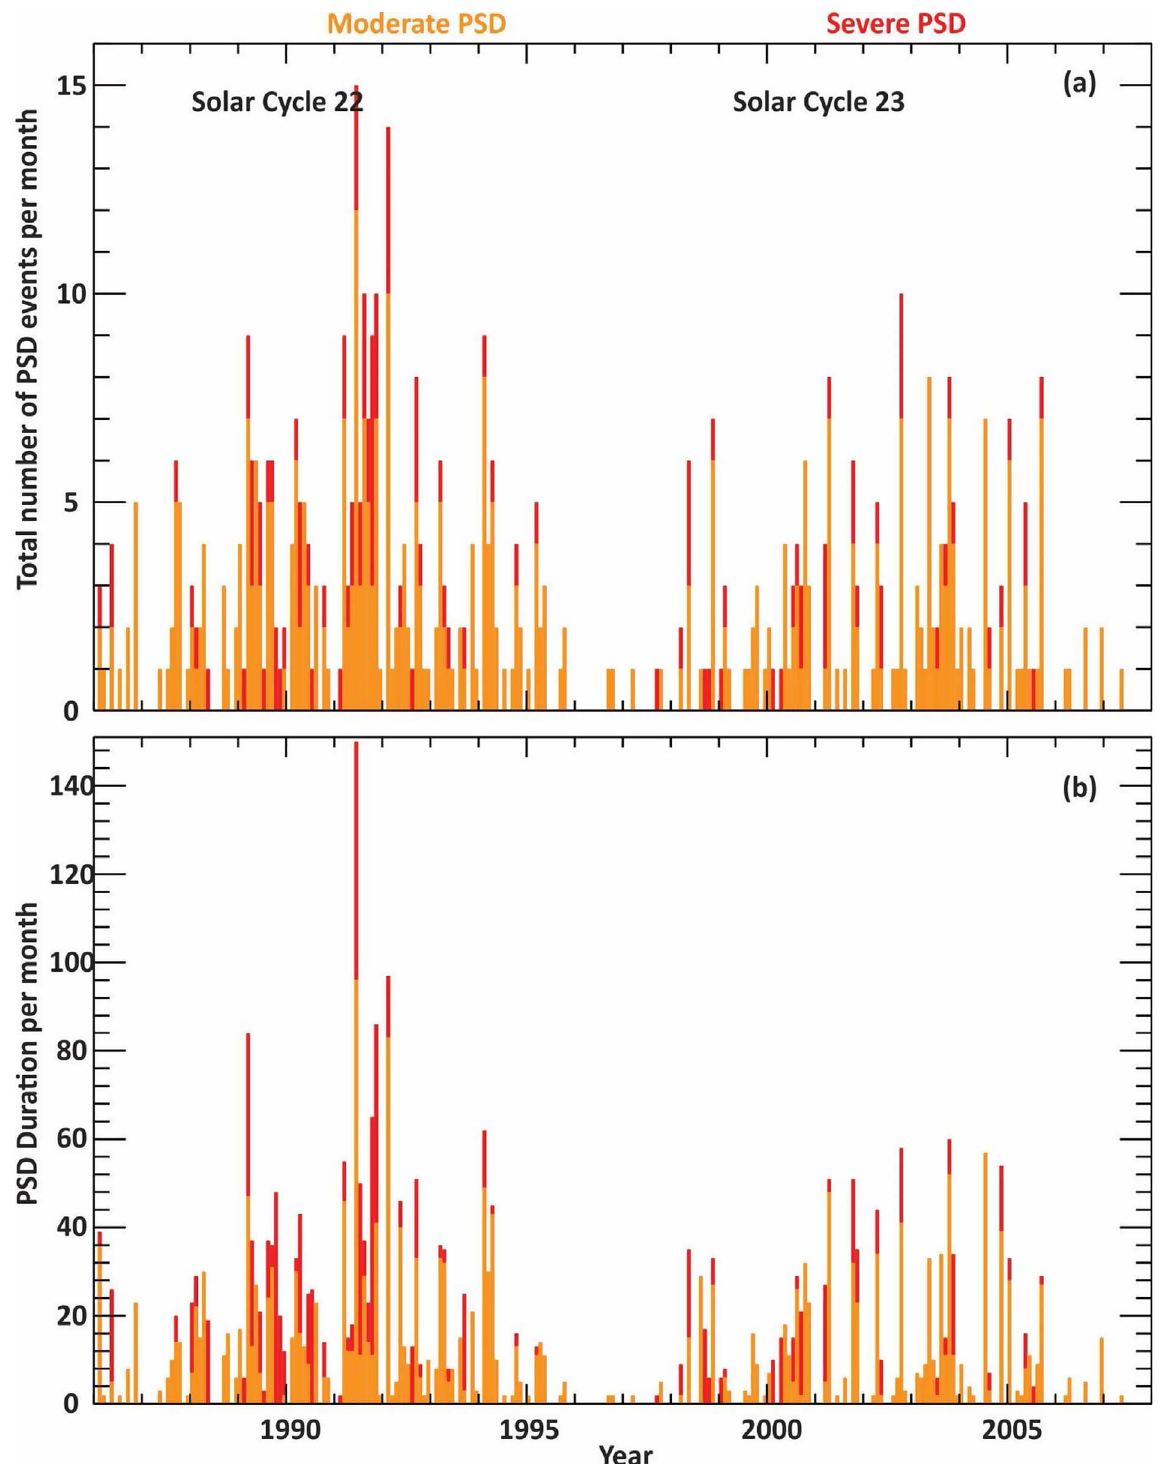
Fig. 5. Bar graph of (a) monthly total PSD events and (b) total number of PSD hours per month for solar cycle 22 and cycle 23. Amounts that are for moderate depression are shown in orange, and the remaining red shades represent severe